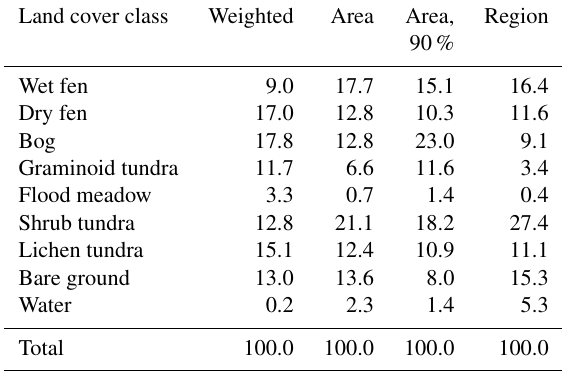
Table 4. Proportions (%) of different land cover classes as weighted by the mean footprint function during the growing sea- son (“weighted”) and their areal coverages within the study area (“area”), within the source area defined by the 90% cumulative footprint (“area, 90%”, Fig. 1a) and within a 35.8km 2 region (“re- gion”, Fig. S2). The marine areas are excluded, and the integrated footprint within the study area is scaled to 100%.